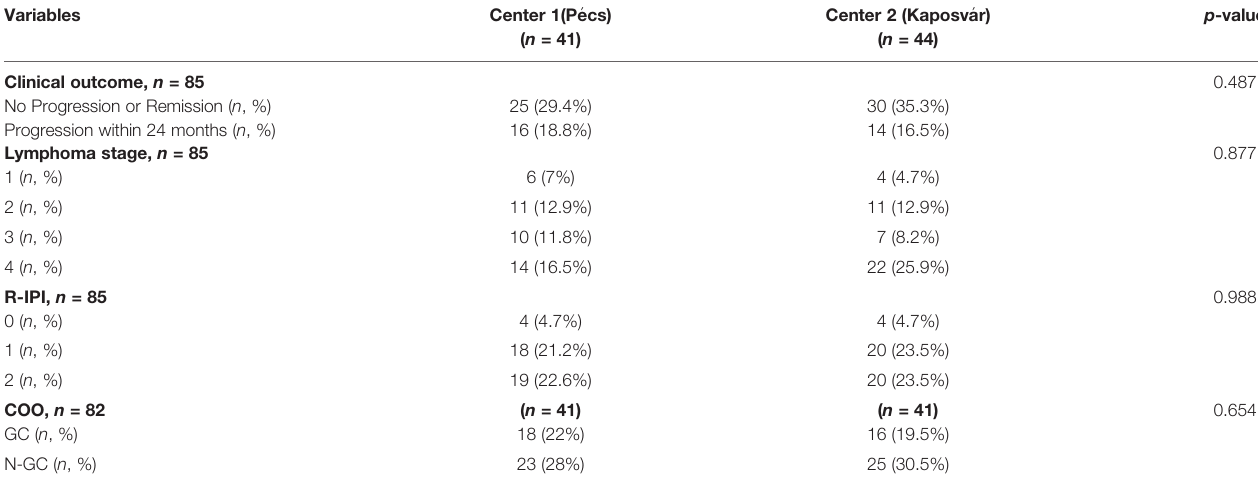
TABLE 2 | Comparison of patients regarding to the two clinical centers where the FDG PET/CT examinations were performed. Variables